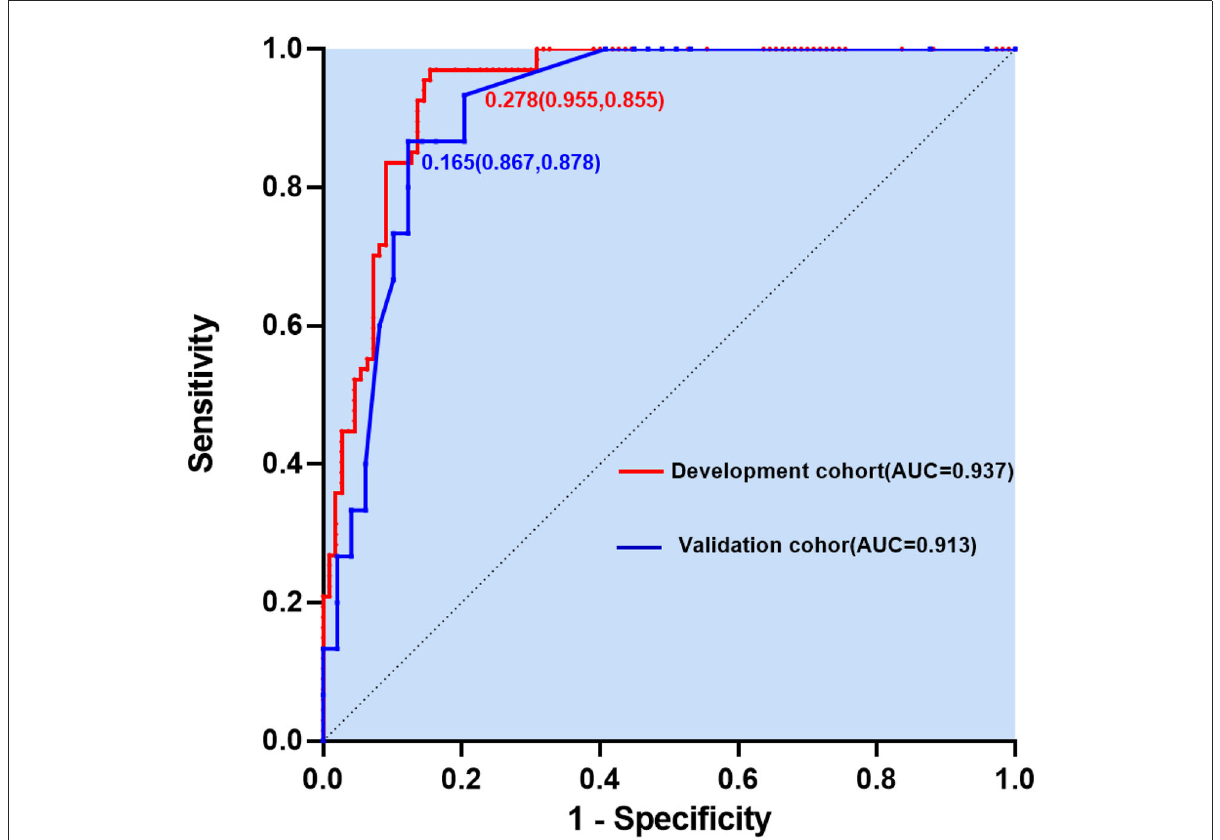
FIGURE3 Calibration curve for the nomogram-predicted probability of AF in